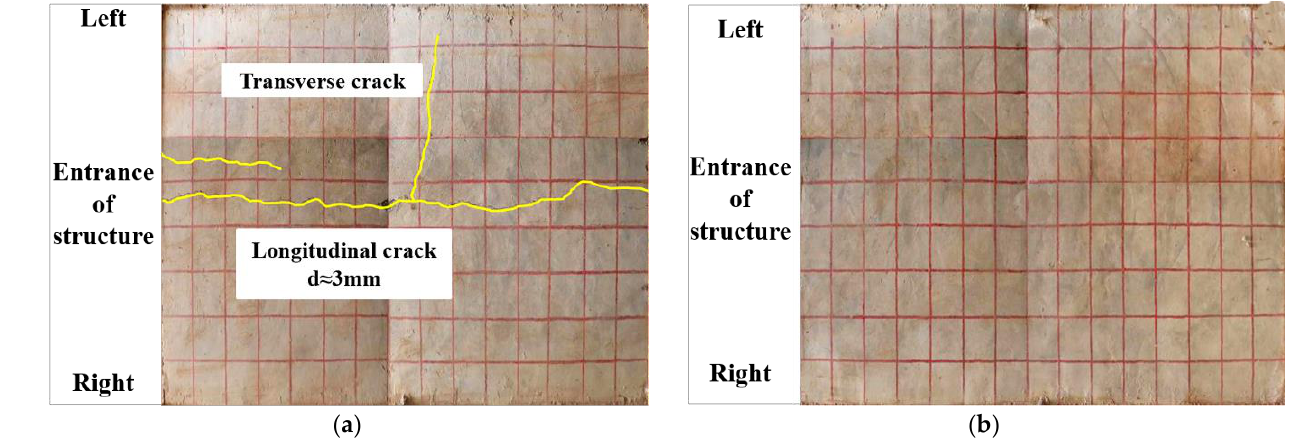
Figure 11. The damage state of the floor: ( a ) test section B; ( b ) test section C.